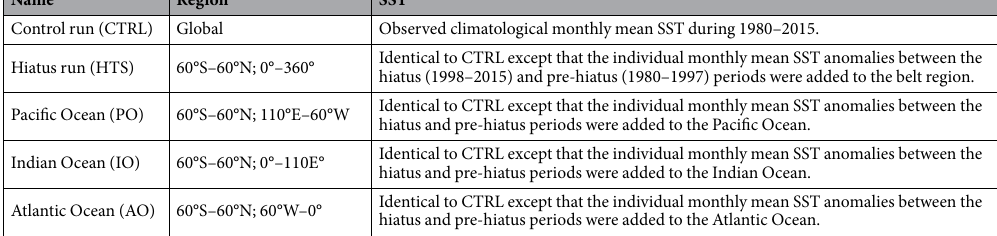
Table 1. Experimental Design of Atmospheric General Circulation Model (AGCM) Simulations.